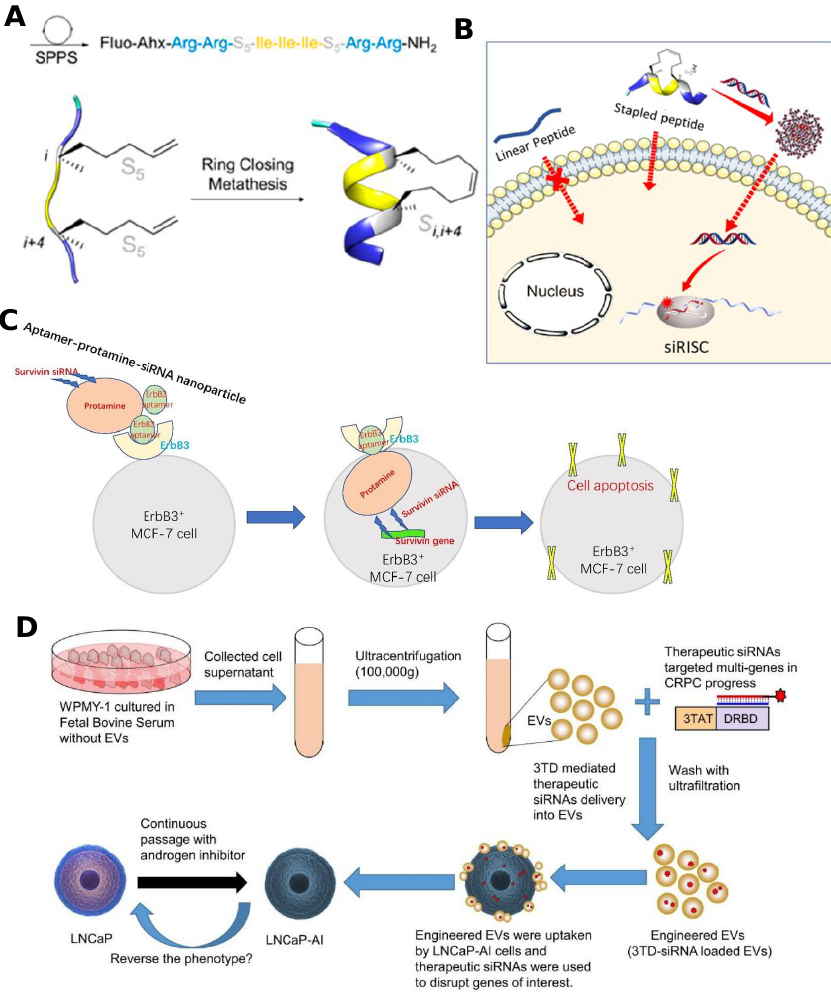
Figure 7. ( A ) Peptide synthesis and gene silencing process ( B ). Fluorescent pin peptides were synthesized by closed-loop metathesis (JMV6337) to encapsulate siRNA and induce gene silencing using short helical pin peptides [110]. Copyright 2020, MDPI. ( C ) Schematic diagram of APR nanoparticle composition and silencing targeted gene expression. APR nanoparticles are composed of ErbB3 aptamer, protamine and siRNA. After entering cells by ErbB3 aptamer recognition, siRNA silenced the survivin gene and induced apoptosis of ErBB3-positive cells [111]. Copyright 2020, Elsevier. ( D ) Schematic diagram of EV delivery strategy of siRNA and predicted therapeutic effect on CRPC cells [113]. Copyright 2022, Informa UK